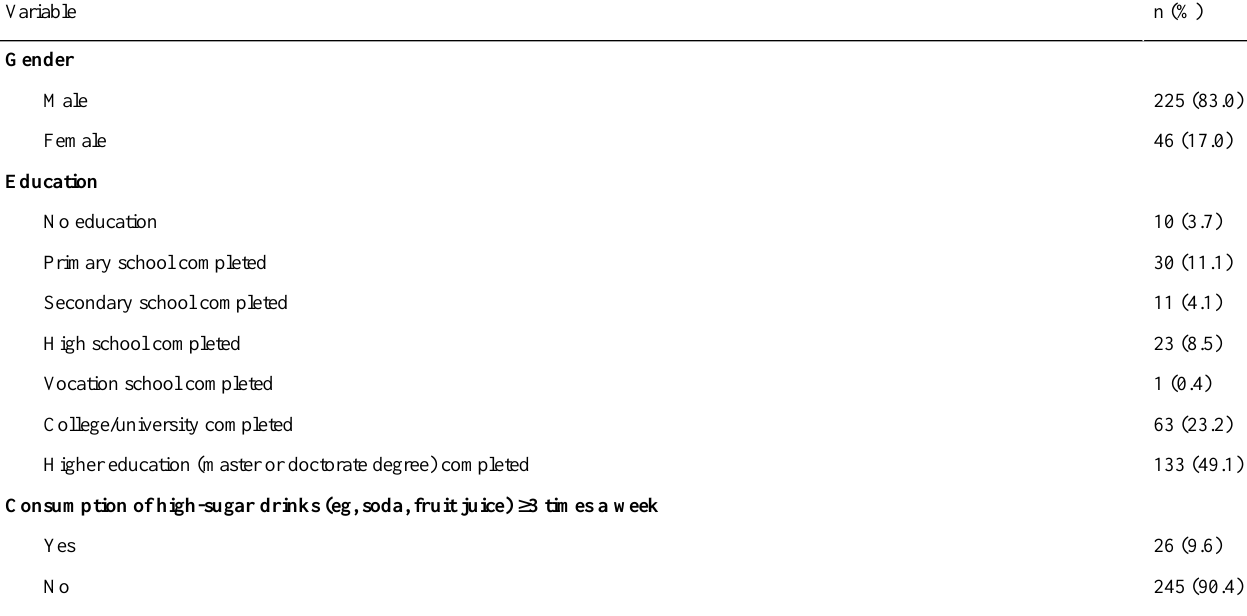
Table 2. Summary statistics of selected categorical predictors related to lifestyle factors (N=271).